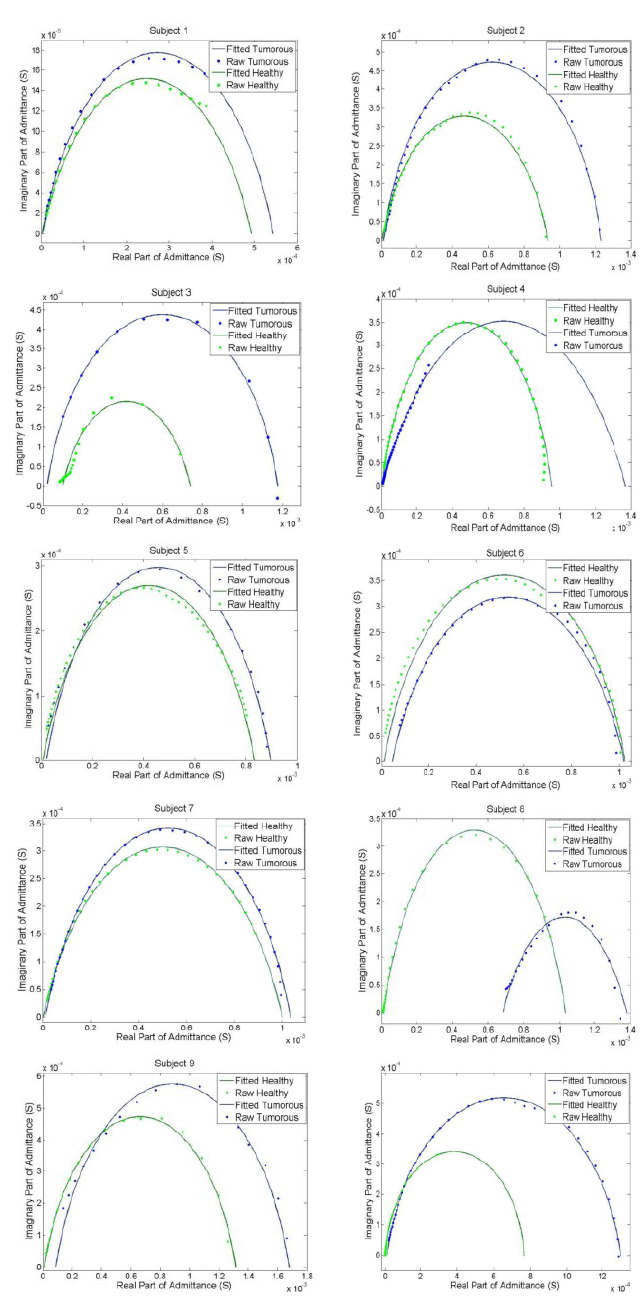
Figure 8: Admittance plot of the tumorous subjects and the contralateral healthy